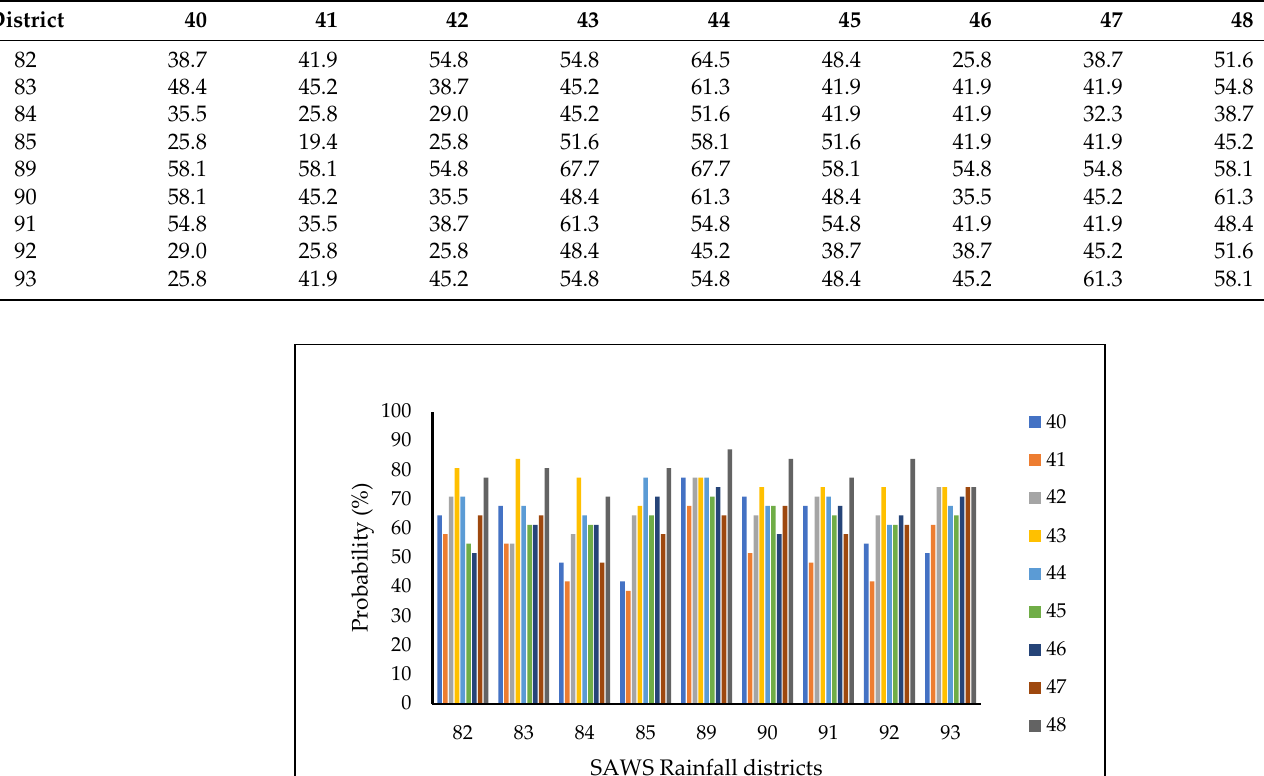
Table 3. Conditional dry-spell probability table (%) of SAWS rainfall districts during the mid-January- to-end-of-February period (pentads 40 to 48) from 1985 to 2015.